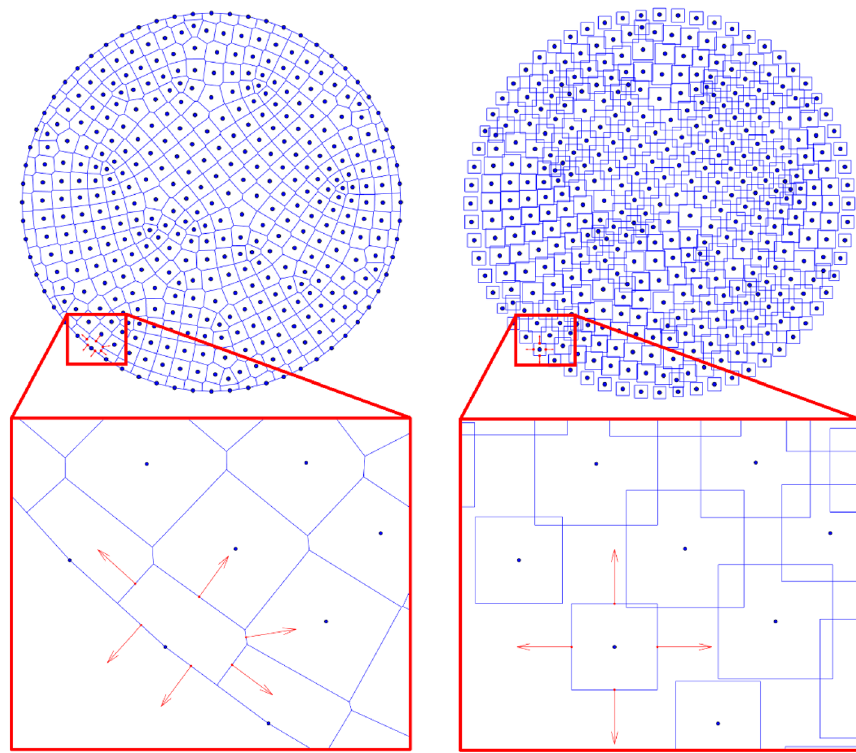
Fig. 4 Smoothed integration cells: stabilized conforming nodal integration using a Voronoi diagram (SCNI; left); stabilized non‑conforming nodal integration (SNNI; right); red arrows from the cells are the outward normal